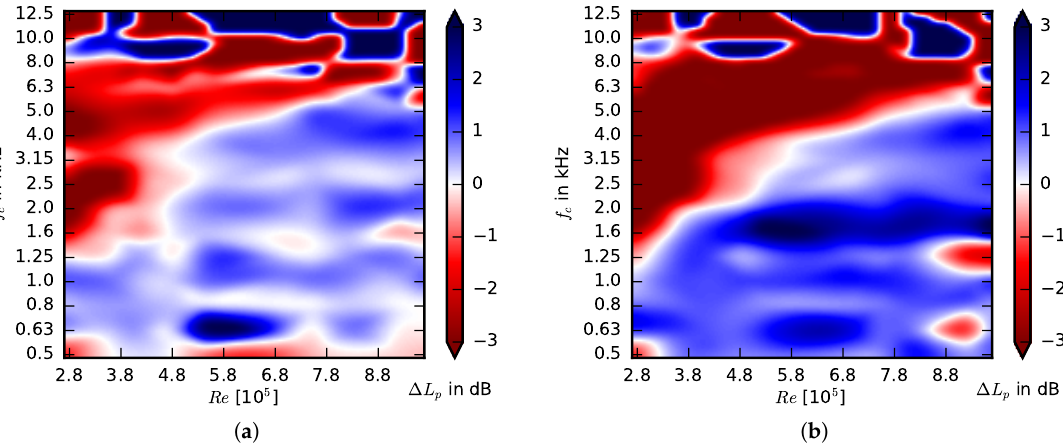
Figure 12. Leading edge sound pressure level difference ∆ L p according to Equation (4) for the airfoils with teeth of alternating length, angle of attack 6 ◦ , PPS 12/2 turbulence grid (positive values denote a noise reduction due to the modifications, negative values a noise increase), ( a ) airfoil 5, h / c l = 0.06, 0.1, s / c l = 0.019, straight, ( b ) airfoil 11, h / c l = 0.06, 0.1, s / c l = 0.019,